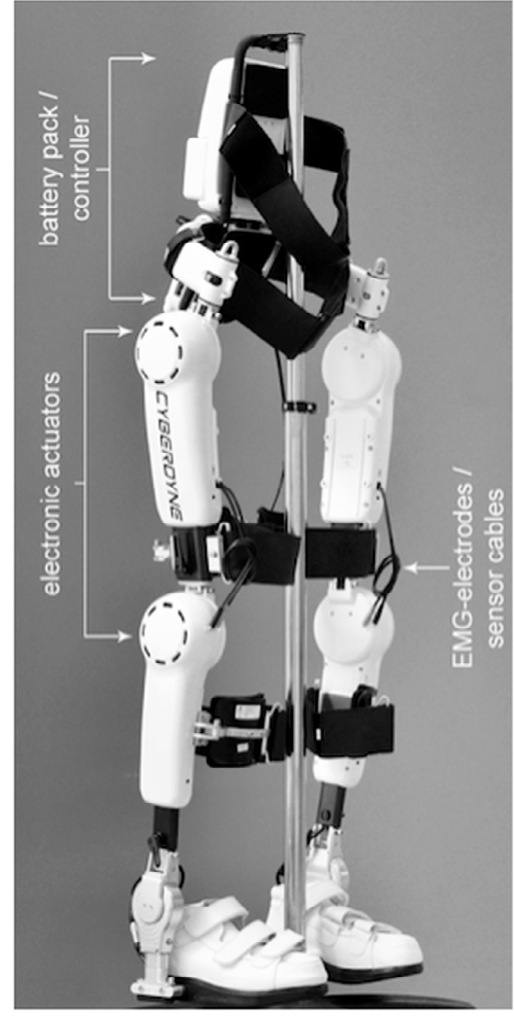
Figure 1. HAL ® —Hybrid assistive limb exoskeleton (Cyberdyne Inc.)